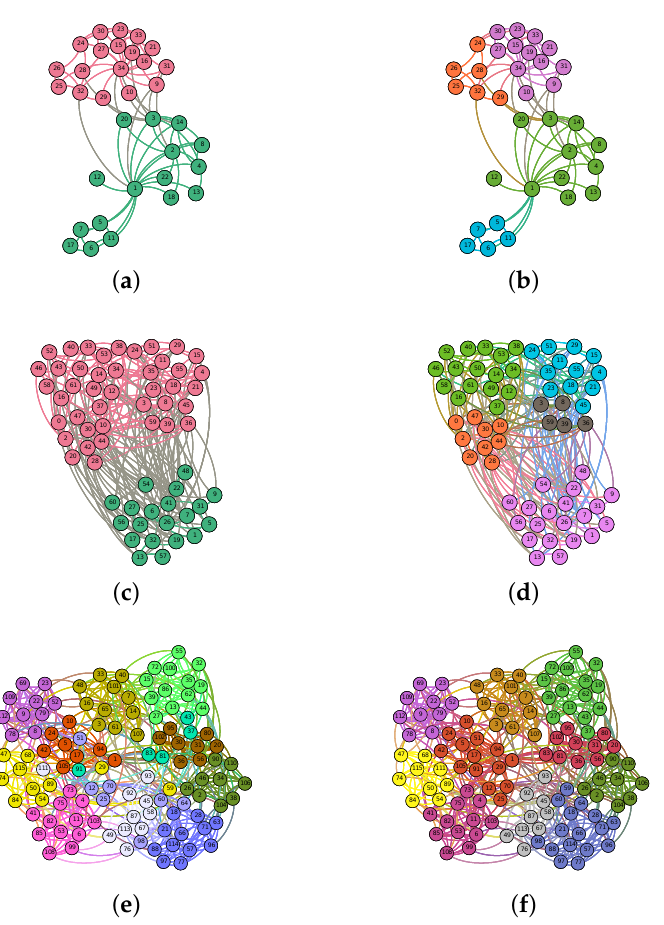
Figure 13. Community structure of three networks. ( a ) Ground-truth communities of Karate network. ( b ) Communities detected by NIGWO of Karate network. ( c ) Ground-truth communities of Dolphins network. ( d ) Communities detected by NIGWO of Dolphins network. ( e ) Ground-truth communities of Football network. ( f ) Communities detected by NIGWO of Football